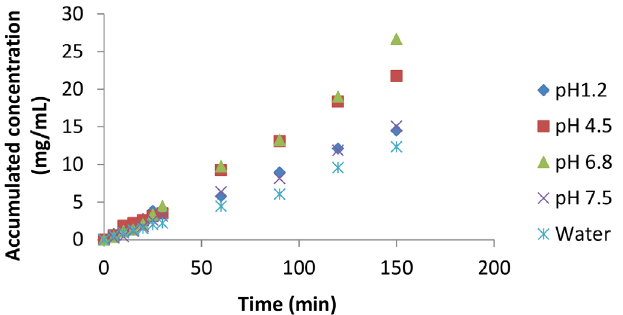
FIGURE 2 - Accumulated concentration (mg/mL) versus time (min) profile for ddI in buffer solutions pH 1.2, 4.5, 6.8, 7.5 and purified